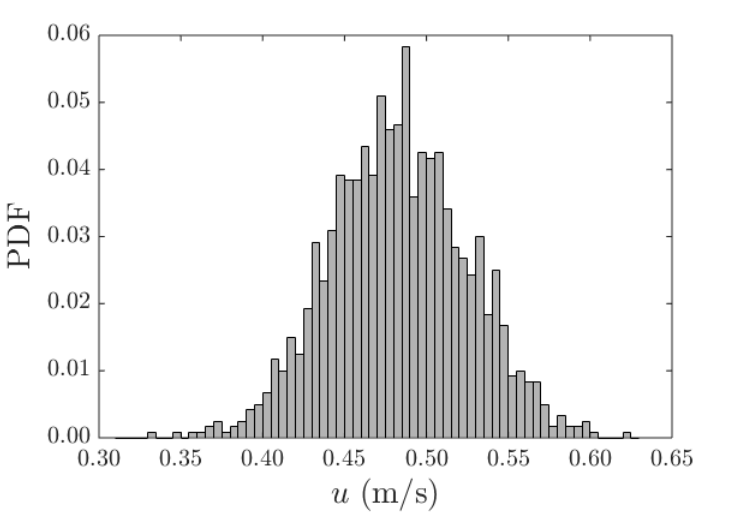
Figure 5. Normalized histogram of the lowpass filtered longitudinal velocity obtained at the reference elevation in test